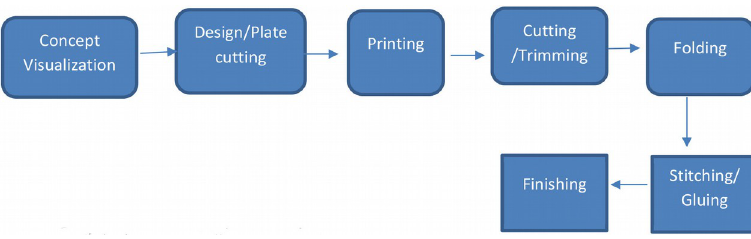
Figure 2. Value Chain of AB Production line